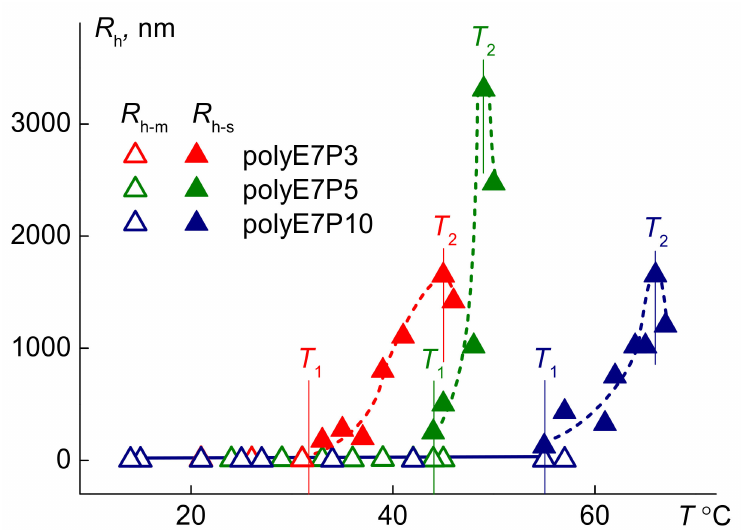
Figure 7. Temperature dependences of the hydrodynamic radii R h-m and R h-s for the aqueous solutions of polyOEGeOPGpMA at concentration c ≈ 0.0050 g · cm − 3 . I 21 is light scattering intensity at 21 ◦